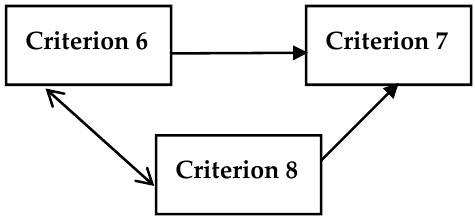
Figure 4. Impact-relation map for the criteria of noncommunicable diseases.